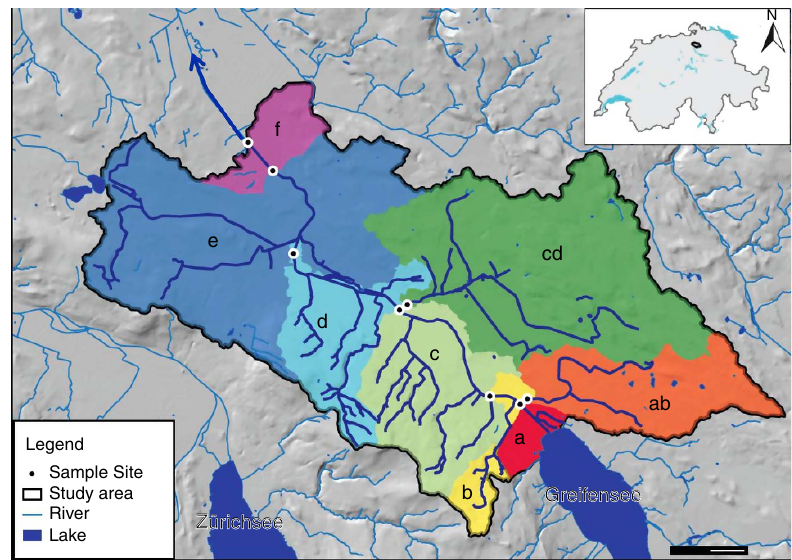
Figure 1 | Study area and location of sampling sites where environmental DNA samples and classical sampling methods were carried out. The direction of flow for the river Glatt is northwest (blue arrow). The main stem of the river originates from the outflow of lake Greifensee. Scale bar, 2km. Coloured regions represent the catchment upstream of each sampling point. Letters are used to indicate the position in the river network starting from the outflow ‘a’ to ‘f’ and the two sampled tributaries ‘ab’ and ‘cd’. Sources for GIS data were from Swisstopo (DHM25, Gewa¨ssernetz Vector 25) and reprinted with